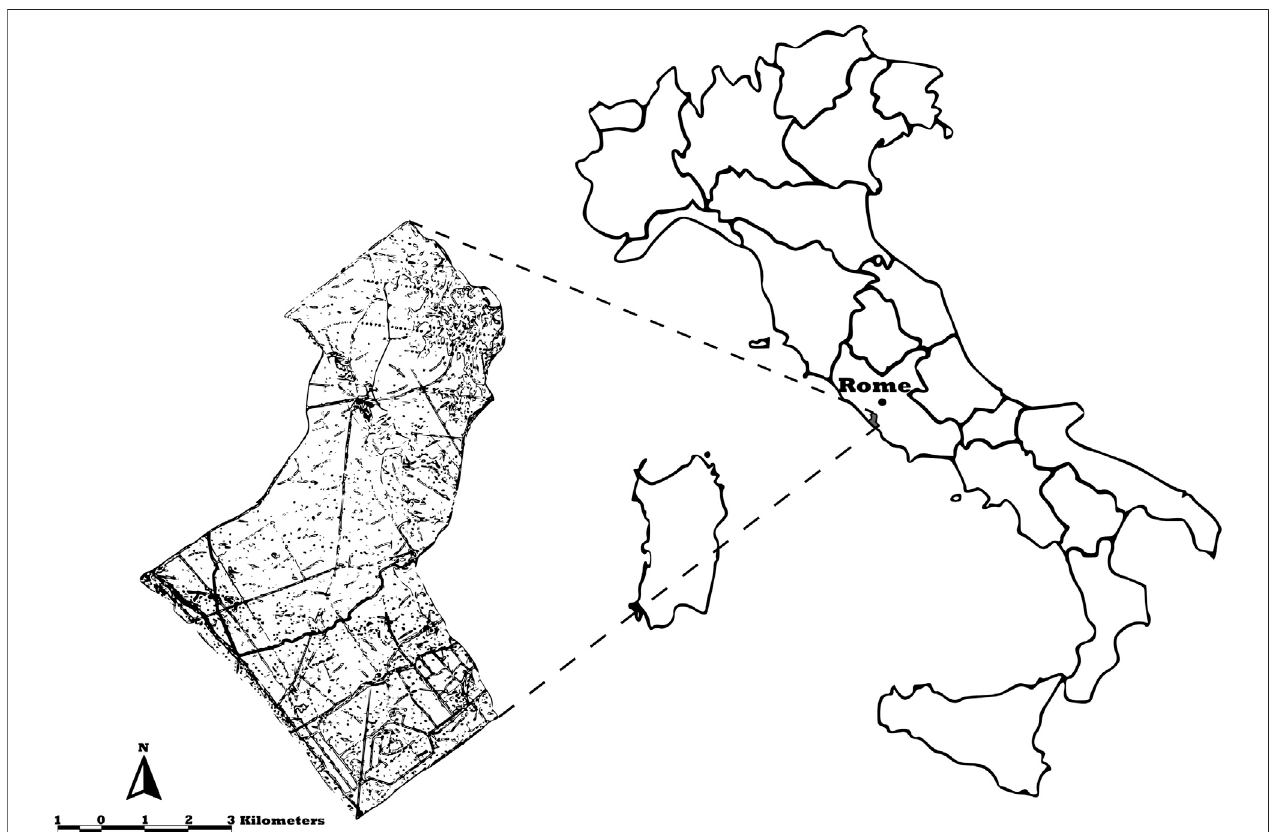
FIGURE 1 | Study area, Castelporziano Nature Reserve (Central